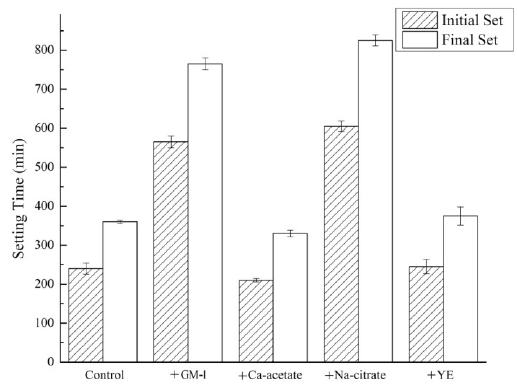
Figure 6 . Initial and final settingtime of cement pastes. Figure 6. Initial and final settingtime of cement